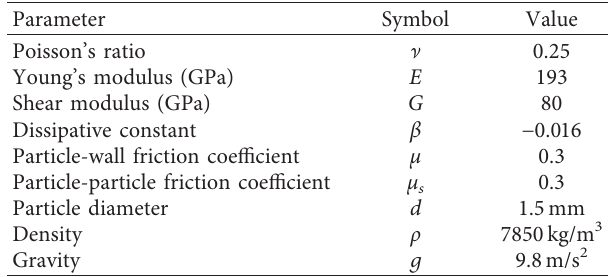
Table 1: DEM parameters and material properties in this work.